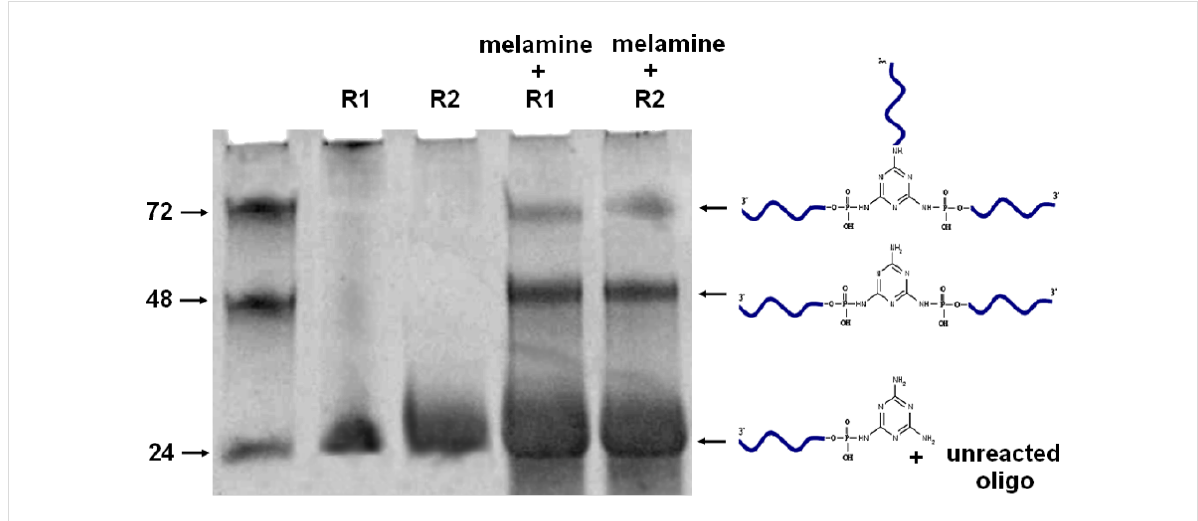
Figure 1: 30% denaturing PAGE analysis of the reaction mixture of ssDNA and melamine.